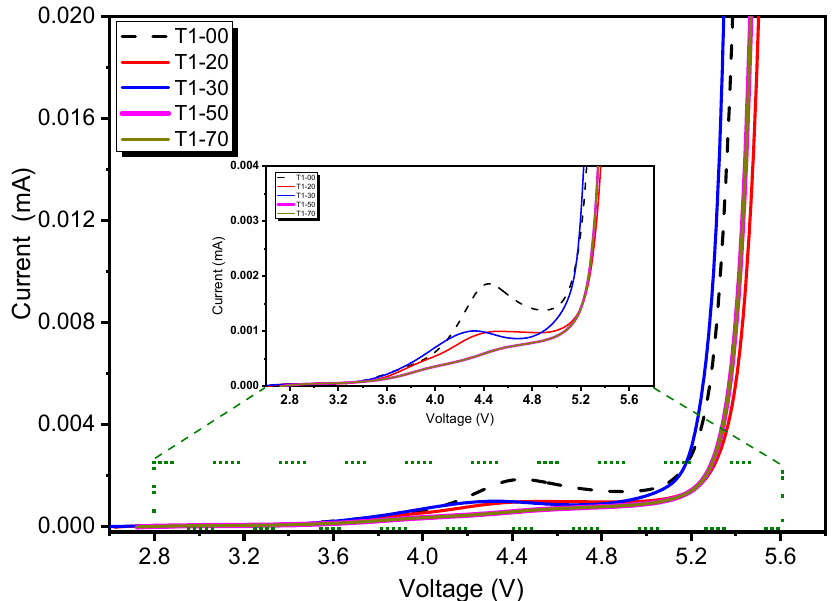
on the lithium metal [27]. The amino/epoxy networks would suppress dendrite crossover during long-term cycling and prevent short circuit occurrence. Figure 6. Linear sweep voltammetry (LSV) measurements of T1 series SPE membranes. To study the interface stability between the SPE and the Li metal, strip-plate tests on Li°|SPE|Li° symmetric cells were carried out on the SPEs at 80 °C and a current density of 0.1 mA cm − 2 (Figure 7). For the T1-00 test, a short circuit was observed after 130 h. This implied the presence of the dendrite crossover during the lithium plating/stripping pro- cess. On the other hand, no short circuit was observed for the T1-20 sample during cycling over 450 h. This may be attributed to the formation of a favorable solid electrolyte interface